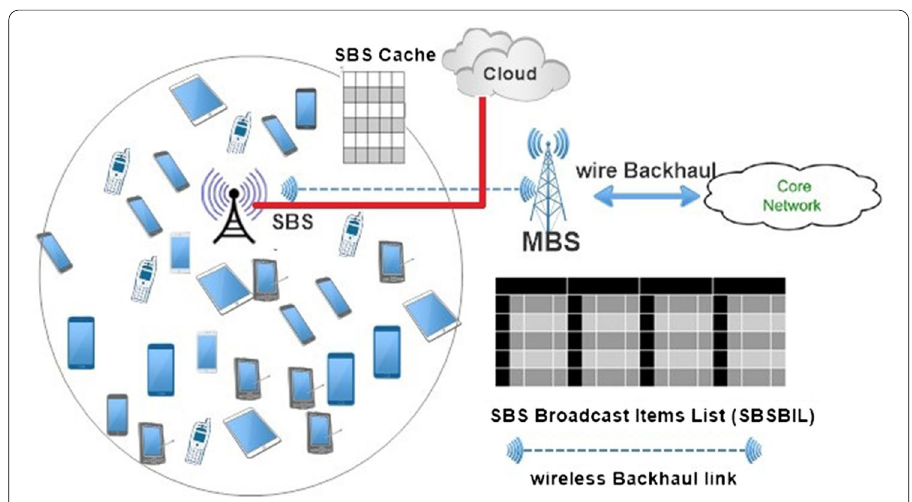
Fig. 1 Uplink cache transmission Small Base Station with